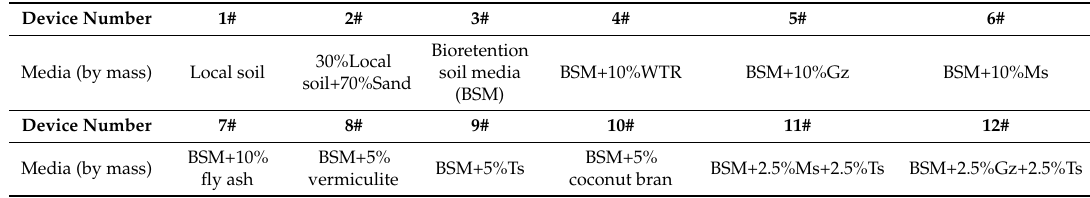
Table 1. Twelve bioretention